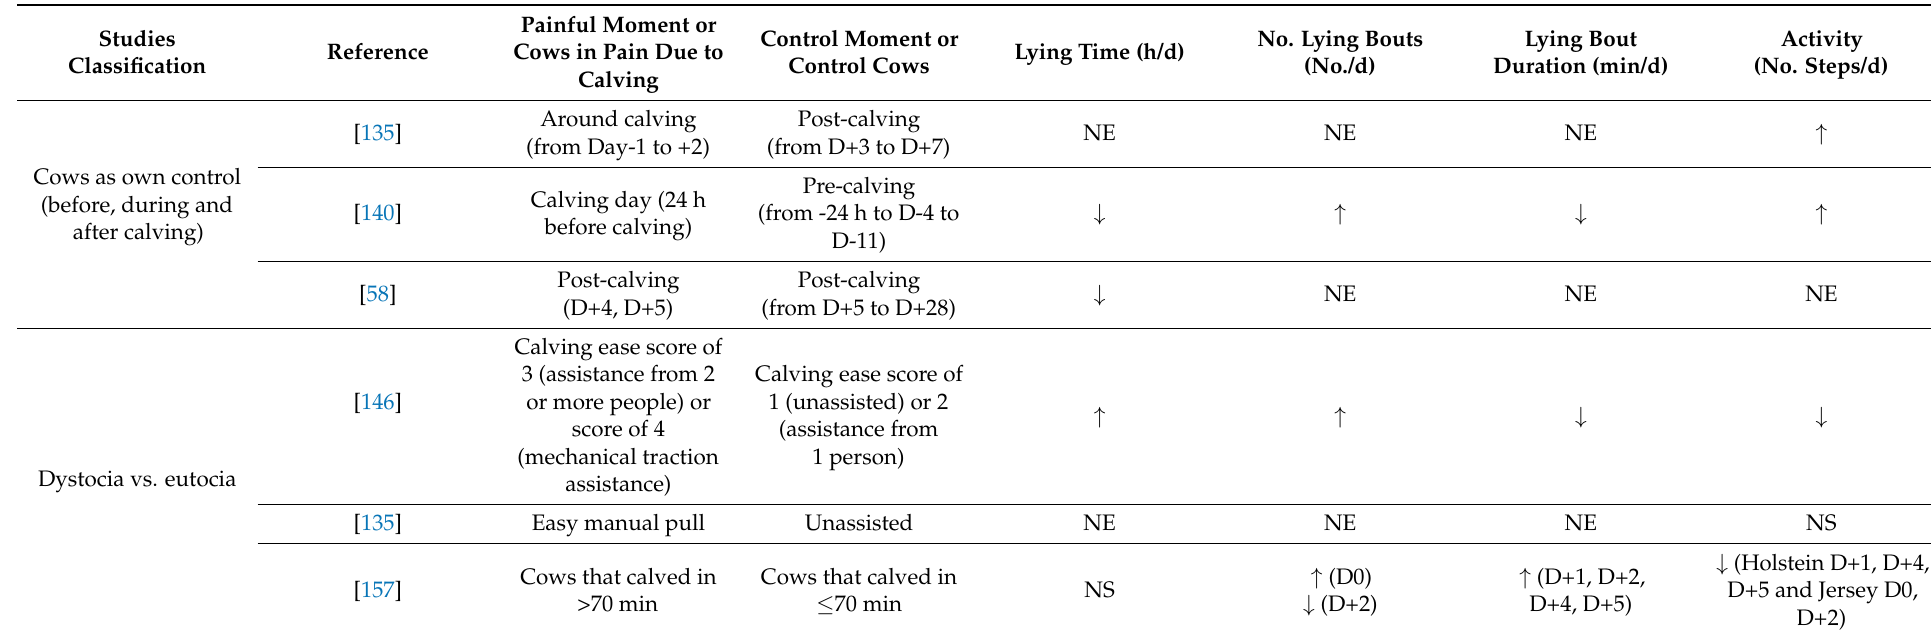
Table 4. Summary of changes in activity patterns in cows (lying time, number of lying bouts, lying bout duration and activity) caused by calving. Studies are summarized according to how they have been assessed in relation to pain using the following methods: cows studied as their own control (before, during and after calving) and comparing cows with dystocia to eutocic calving. Moment (in days, D; D0 = day of calving) and type of change ( ↑ increase; ↓